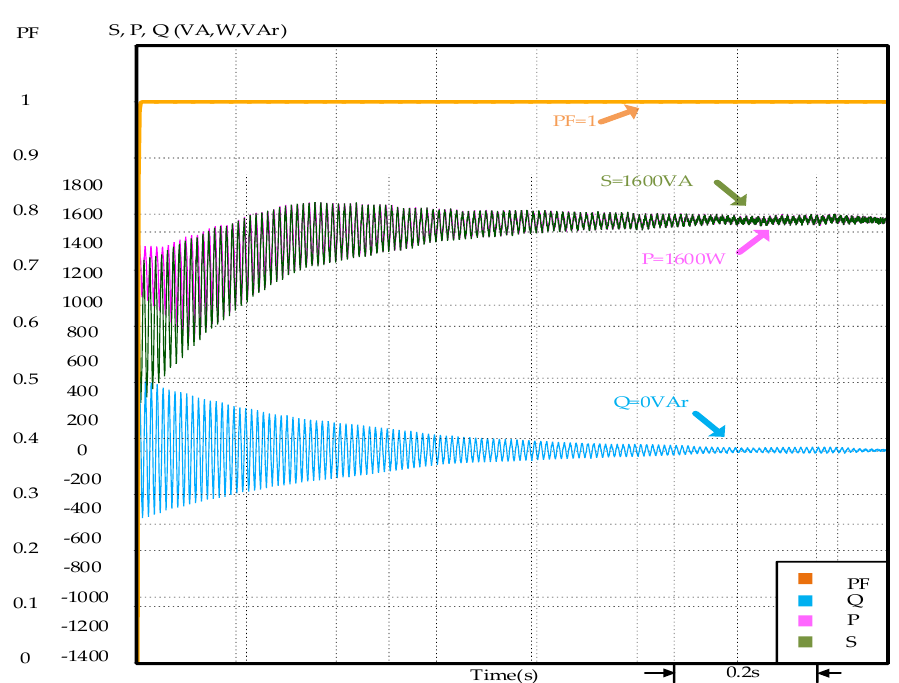
Figure 11. The output PF, real power, reactive power, and apparent power of the smart inverter when the per-unit value of mains voltage equals 1 p.u.